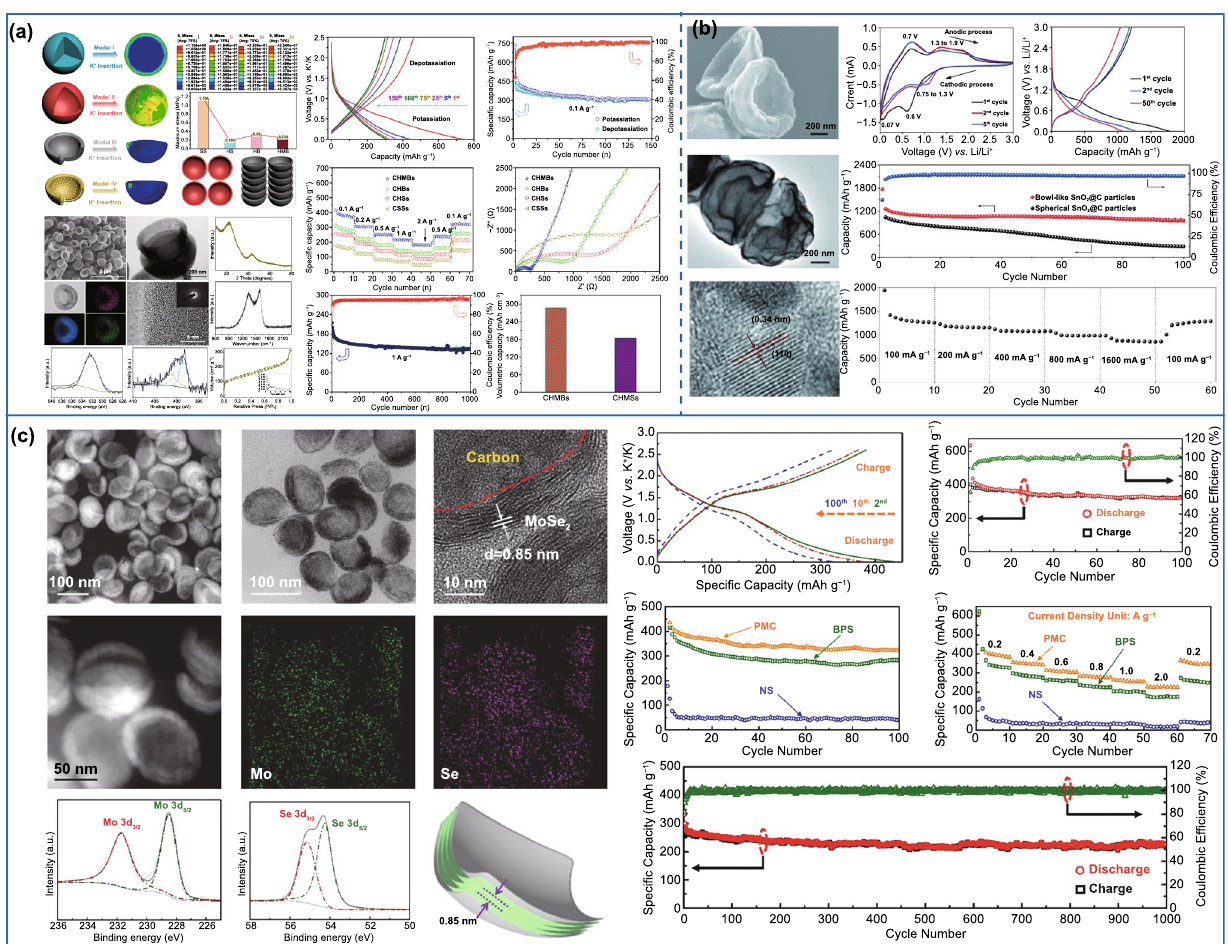
Fig. 10 Application of asymmetric structure in secondary batteries. a Application of asymmetric pure carbon in secondary batteries. Repro- duced with permission from Ref. [130]. Copyright 2019, American Chemical Society. b Application of asymmetric SnO 2 @C composite mate- rial in Li-ion batteries. Reproduced with permission from Ref. [132]. Copyright 2014, Wiley–VCH. c Application of asymmetric MoSe 2 /C com- posite material in K ion batteries. Reproduced with permission from Ref. [43]. Copyright 2019, American Chemical